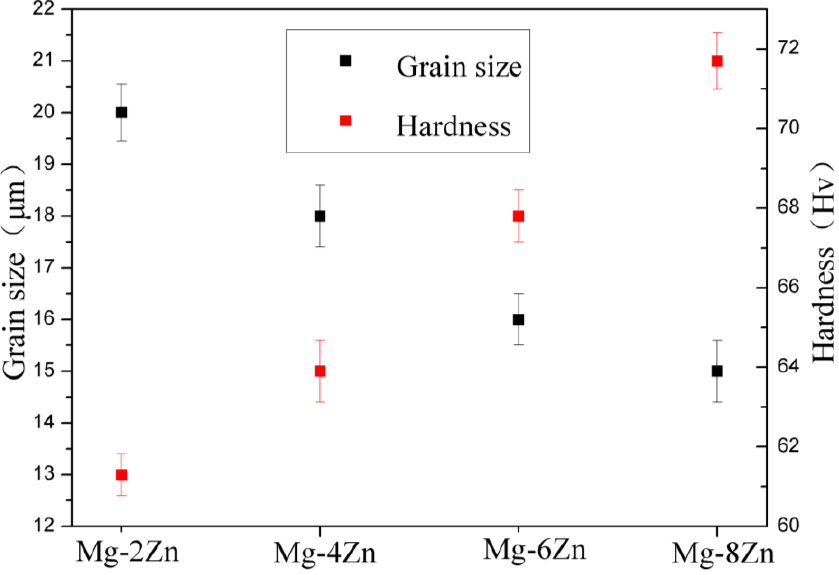
Figure 8. The grain size and hardness of the Mg-Zn alloys.